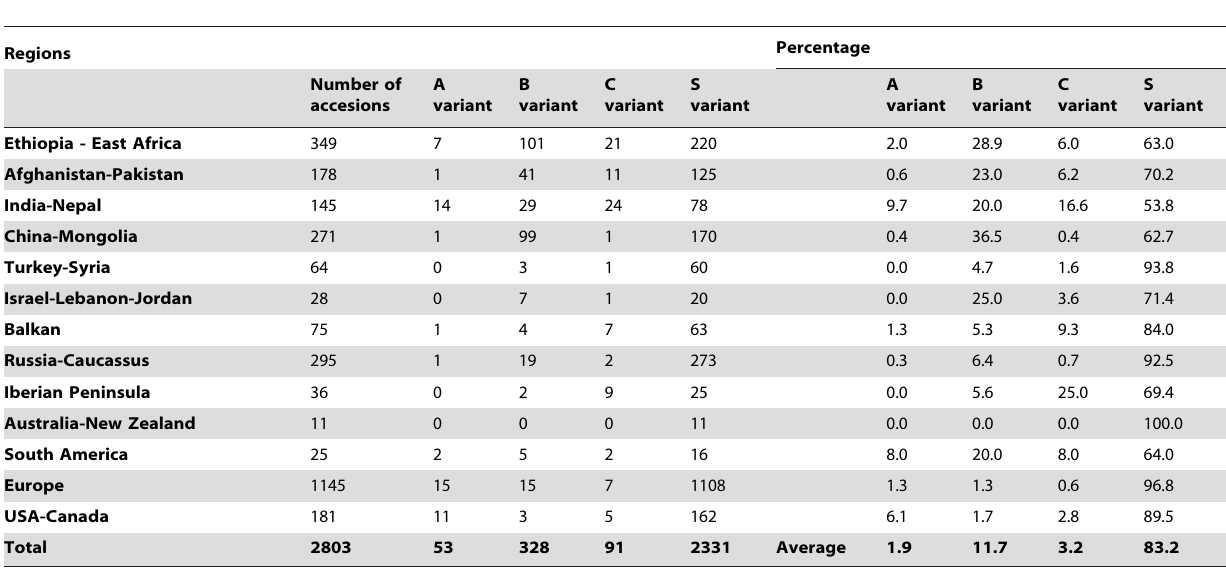
Table 2. Summary of germplasm screening of 2803 pea accessions, indicating four principal eIF4E intron 3 length variants (A-B-C and S), distribution in total numbers and percentage over 13 geographical regions.